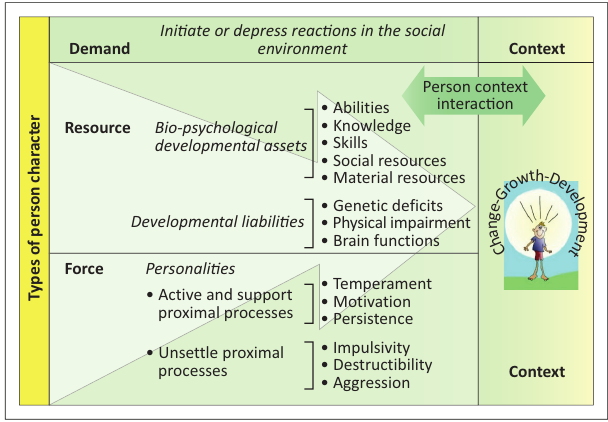
FIGURE 1: The application of the process–person–context–time in child